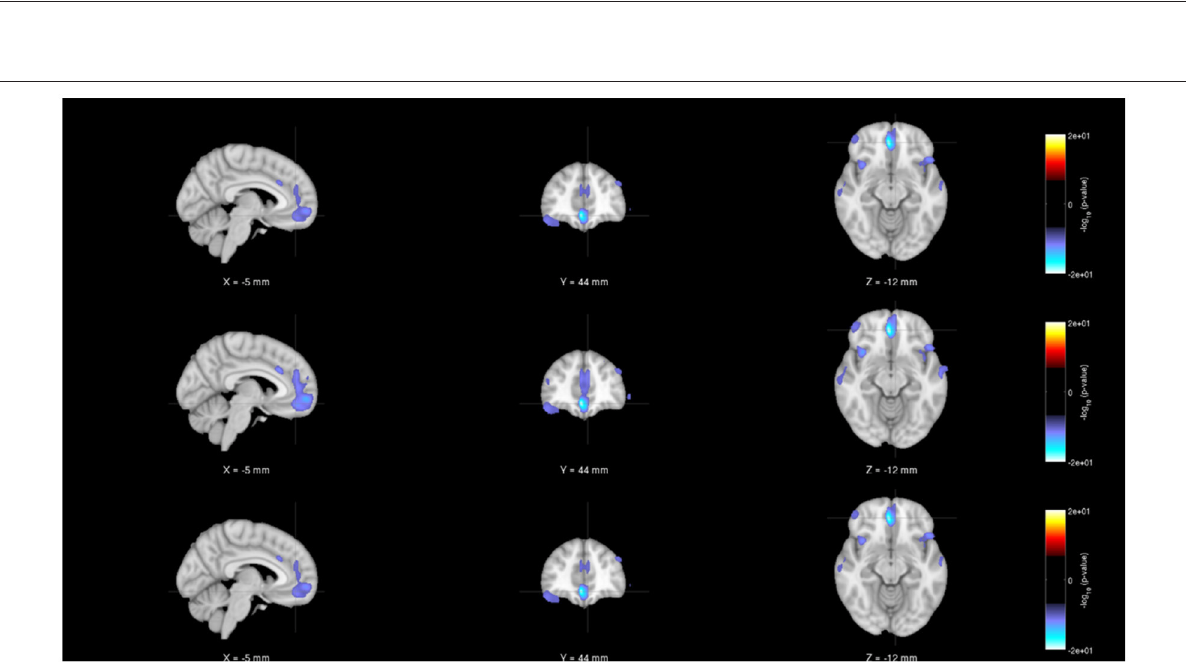
Frontiers in Neuroinformatics | www.frontiersin.org